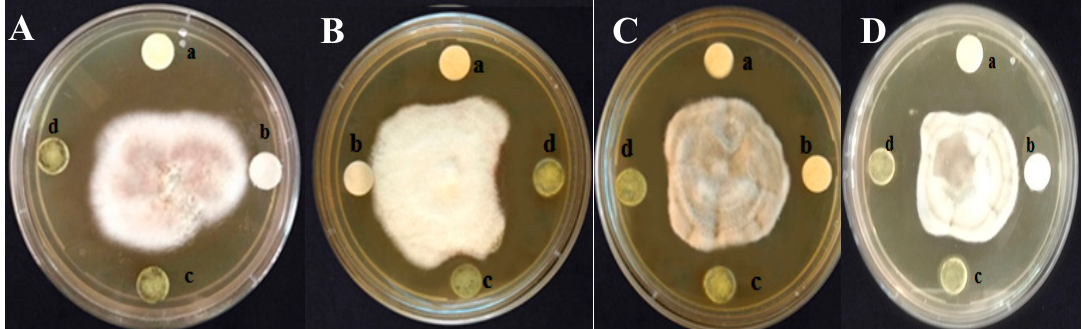
Figure 2. Growth inhibition of ( A ) F. thapsinum , ( B ) E. sorghinum , ( C ) A. alternata and ( D ) C. lunata pathogens were observed by column purified fraction of methanolic extract of E. alba . (a) Bavistin, (b) Control, (c) Ethyl acetate fraction, (d) Purified fraction of Methanolic extract of E. alba. Table 2. Percentage growth inhibition exhibited by E. alba extract by Microtiter plate assay. Target Pathogens (Percent Growth Inhibition) Concentration of E.